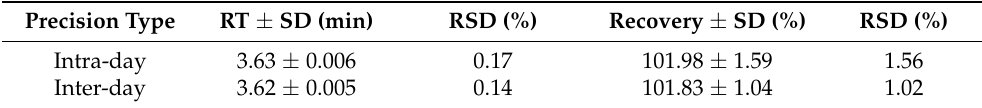
Table 8. Evaluation of intra-day (repeatability) and inter-day (intermediate precision) precision of the UHPLC-HRMS method applied to podophyllotoxin quantification.